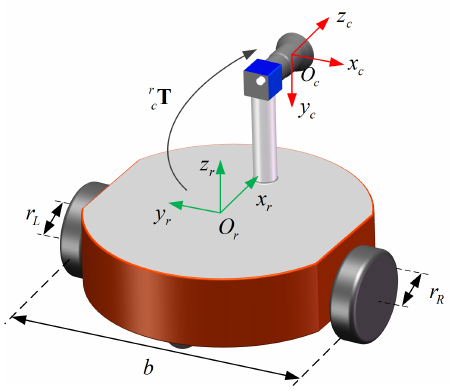
Figure 1. Schematic of a differential-drive mobile robot equipped with a monocular